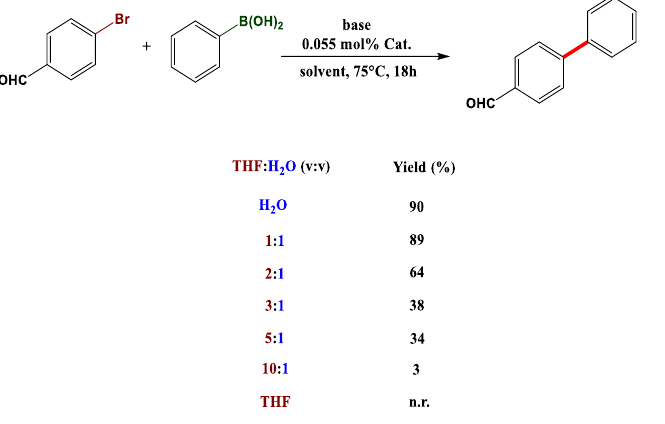
Figure 5. Progressive solvent scale for the reaction. Adapted from Reference [34]. Copyright 2012, Royal Society of Chemistry.